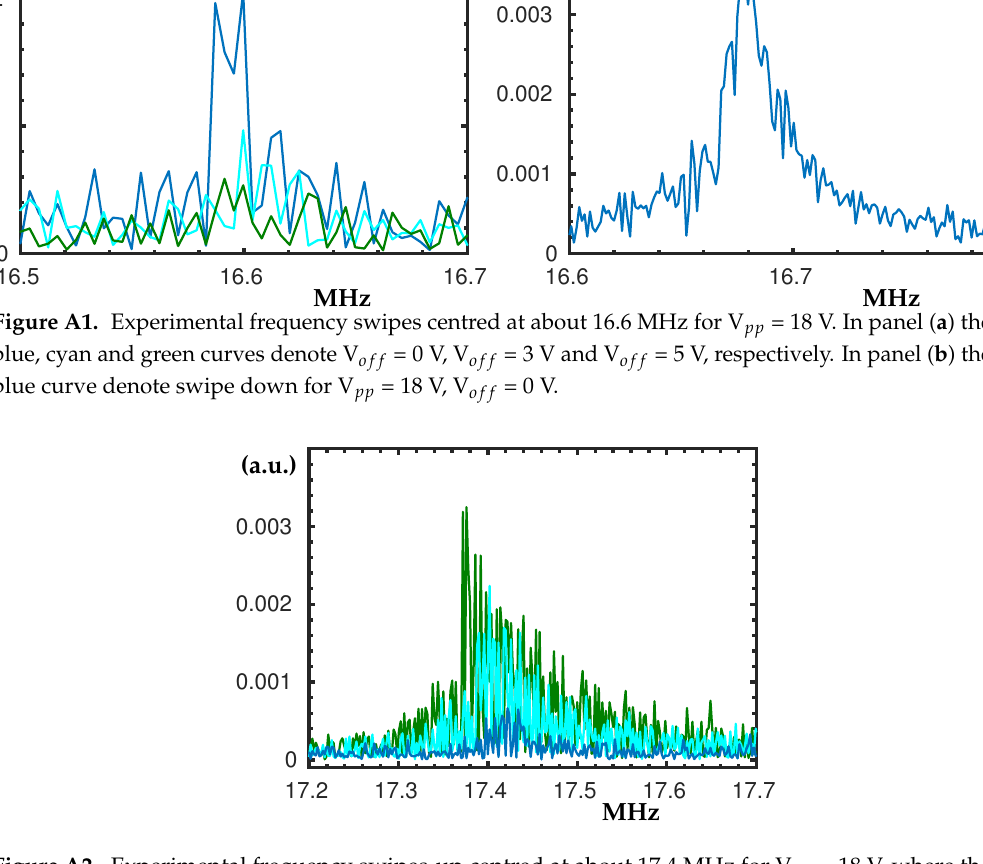
Figure A2. Experimental frequency swipes-up centred at about 17.4 MHz for V pp = 18 V, where the blue, cyan and green curves denote V of f = 1 V, V of f = 3 V and V of f = 5 V, respectively.